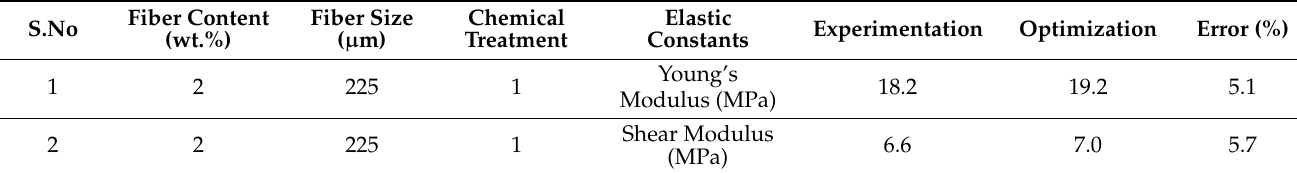
Table 7. Optimized combination of parameters.